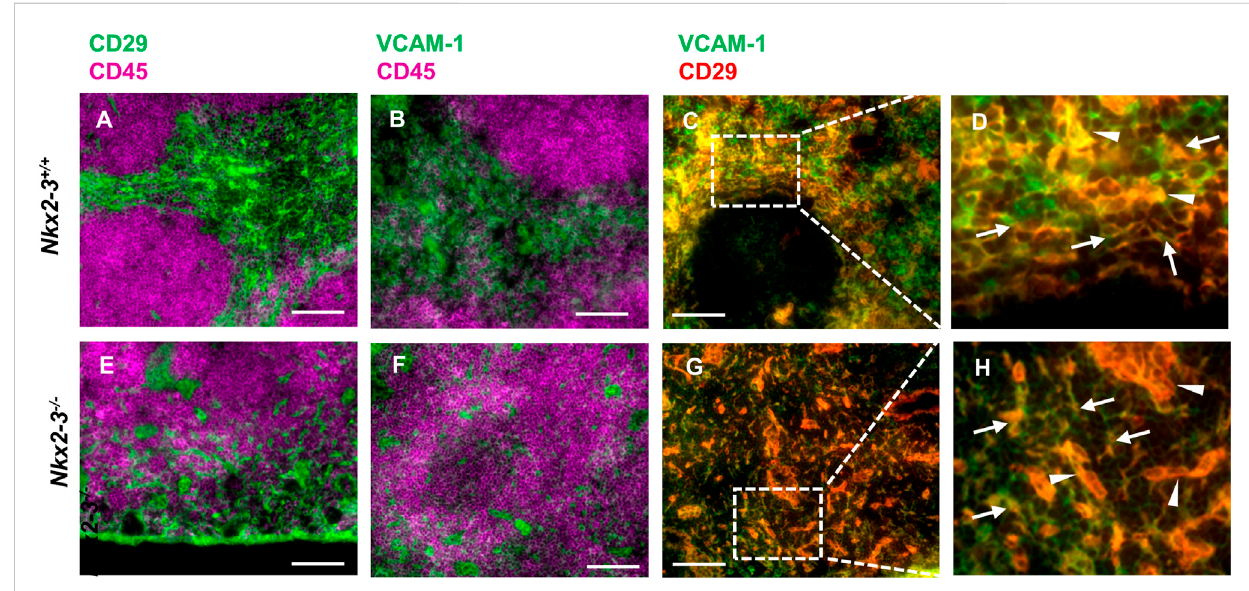
FIGURE 4 Hematopoiesis-supporting splenic stroma is disrupted in Nkx2-3 − / − mice. Cryosections from Nkx2-3 +/+ ( A – D ) and Nkx2-3 − / − spleens ( E – F ) were stained for indicated markers, revealing intense expression of both CD29 and VCAM-1 (green) outside the white pulp delineated by CD45 staining (purple). Higher power images of the rectangles within the RP marked [in (C, G) ] with dashed line demonstrate both stromal (arrows) and vascular (arrowheads) co-expression of CD29 and VCAM-1 [appearing as yellow, (D, H) ]. Representative dual fl uorescence microscopic images from a cohort of n = 4. Scale bars correspond to 100 μ